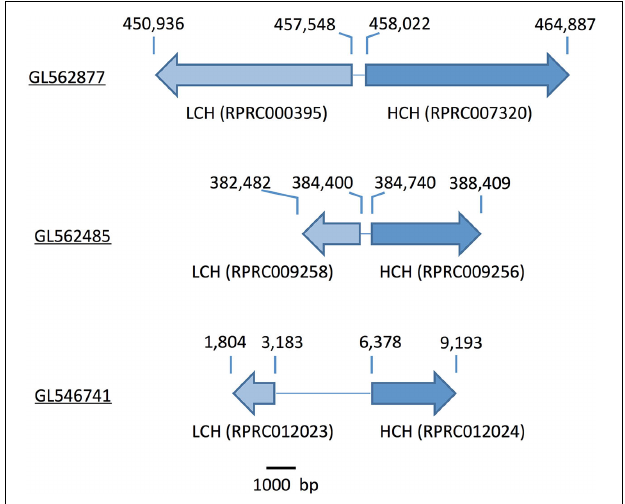
FIGURE 2 | Scheme of the genomic distribution of the secreted HCH and LCH ferritins subunits in the genome of R. prolixus . Scaffold numbers are underlined. The numbers above the arrows indicate the position within the scaffold. Ferritin subunits (gene codes) are indicated below the